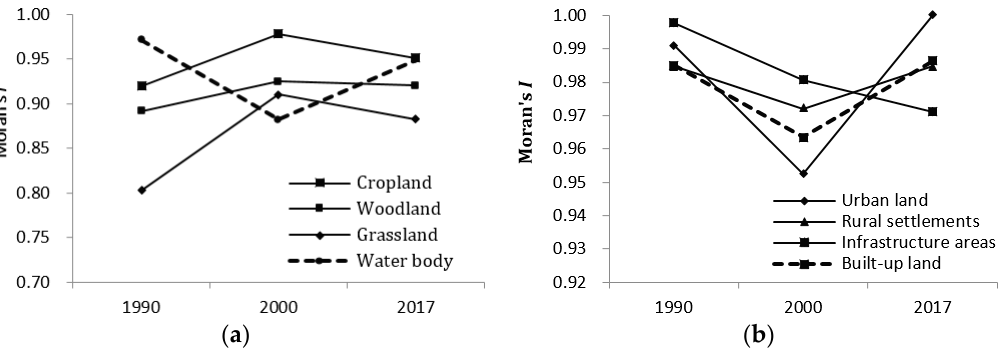
Figure 9. Moran’s I of land-use/cover of study area during 1990 and 2005. Note: unused land was ignored as a result of it being the smallest area (less than 0.01% of total area), ( a ) Moran’s I of cropland, woodland, grassland and water body, ( b ) Moran’s I of urban land, rural settlements, infrastructure areas and built-up land.